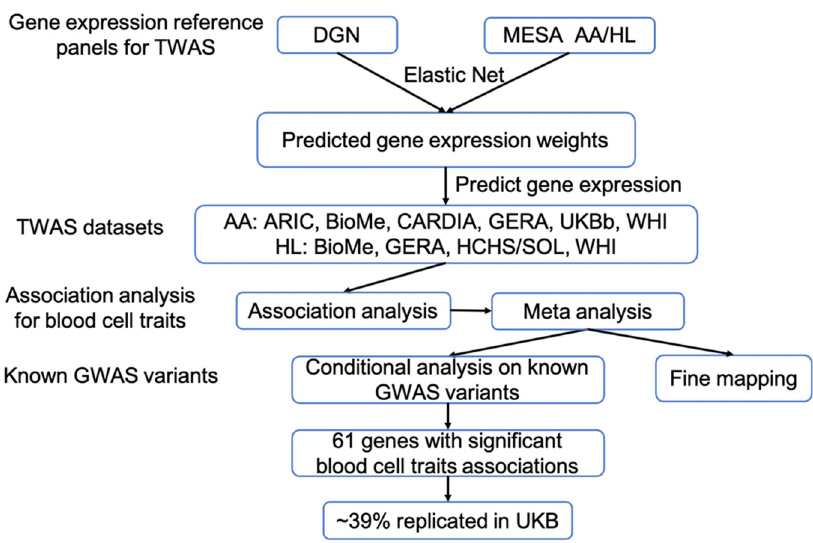
Figure 1. Study design for blood cell trait focused TWAS analyses in African ancestry (AA) and Hispanic/Latino (HL) populations. TWAS: Transcriptome-wide association study; DGN: Depression Genes and Networks, n = 922; MESA: Multi-Ethnic Study of Atherosclerosis, n = 229 for AA and n = 381 for HL; ARIC: Atherosclerosis Risk in Communities, n = 2874; BioMe: BioMe TM Biobank, n = 3550 for AA and n = 4730 for HL; CARDIA: Coronary Artery Risk Development in Young Adults, n = 953; GERA: Genetic Epidemiology Research on Adult Health and Aging, n = 3699 for AA and n = 7348 for HL; UKB: UK Biobank, n = 8262; WHI: Women’s Health Initiative, n = 8617 for AA and n = 4359 for HL; HCHS/SOL: Hispanic Community Health Study/Study of Latinos, n = 11,887.